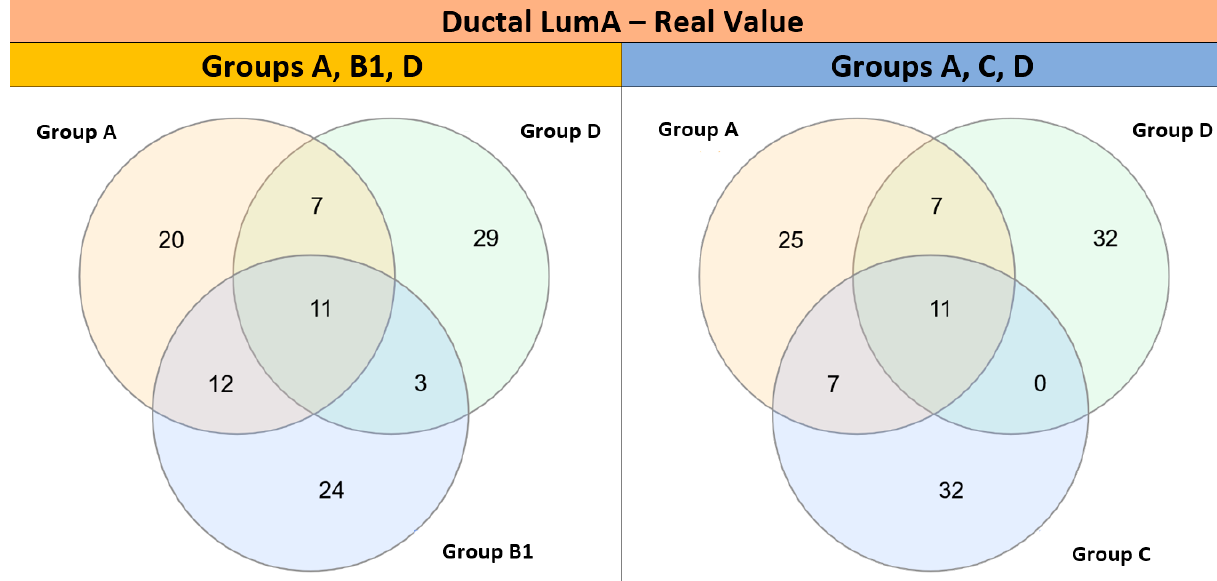
Figure 12. Venn diagrams showing overlapping of top-ranked functional pathways identified in GSEA Analysis II (restricted to 310 invasive ductal carcinomas of the LumA subtype) among different chromogroups.